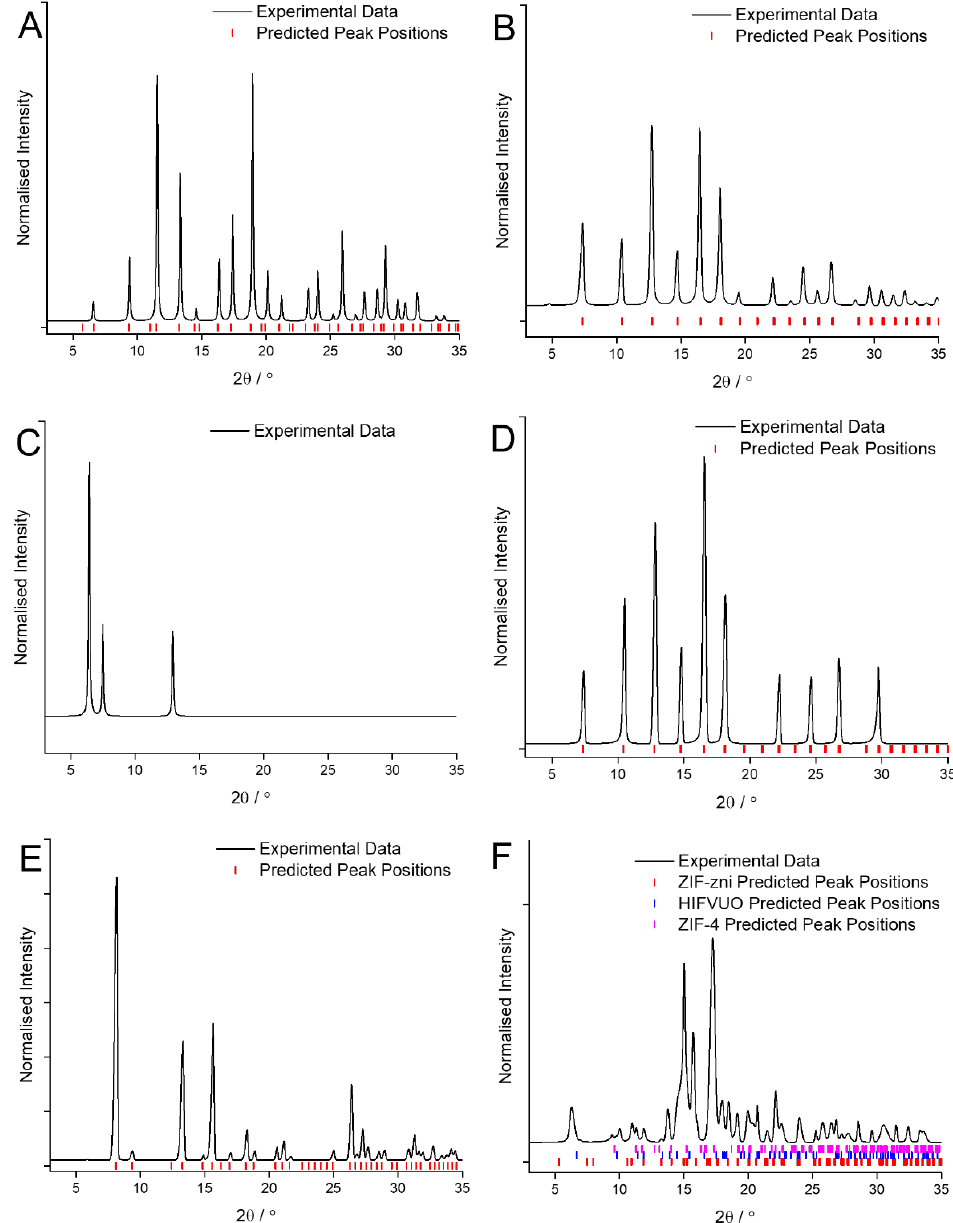
Figure 1. XRD patterns of the MOF coatings obtained using Cyrene TM as the solvent for: ( A ) Cu and BTC; ( B ) Zn and mIM; ( C ) Zn and bIM; ( D ) Co and mIM; ( E ) Zn and eIM; ( F ) Zn and IM compared against predicted peak position values [27,28,30,31].